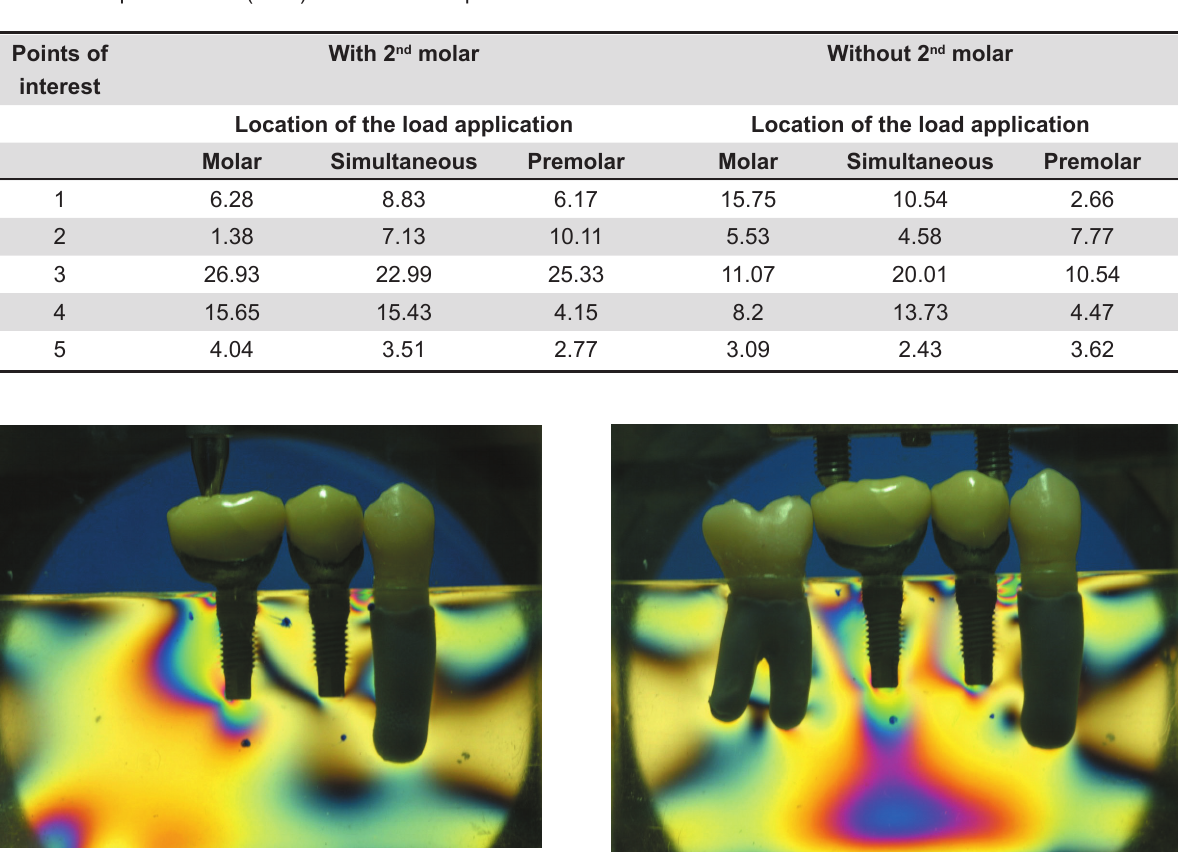
Figure 4- Simultaneous point load (10 kgf) on the second premolar and first molar (model with the second molar replica)